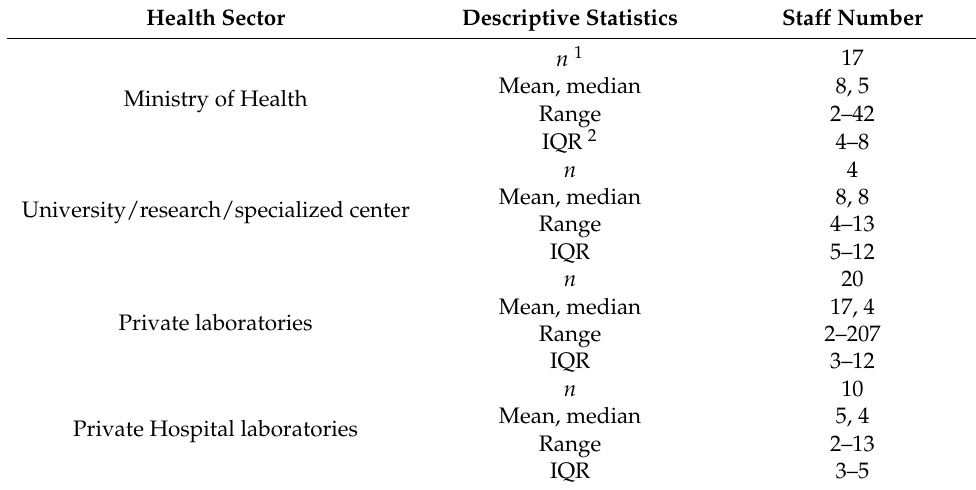
Table 2. Number of laboratory staff capable of performing molecular COVID-19 testing stratified per health